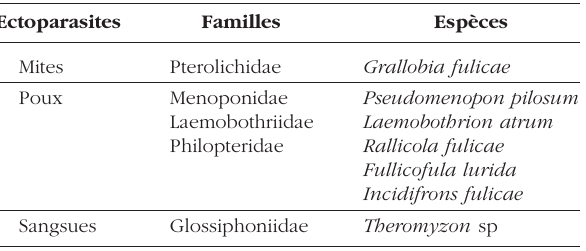
Tableau I. – Espèces d’ectoparasites isolées chez la Foulque macroule.